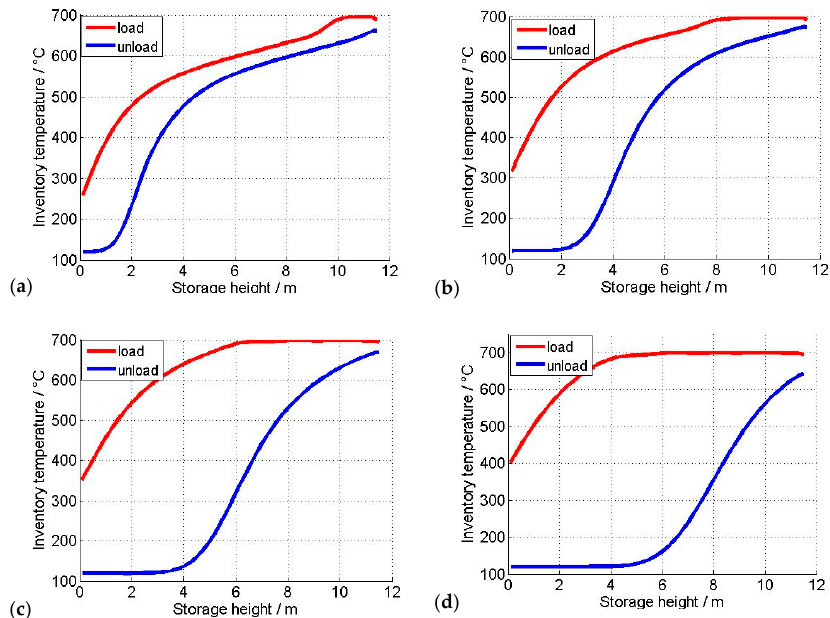
Figure 7. Partial load behavior: Temperature profiles of the inventory versus the storage height at the end of the charging and discharging process ( a ) 25% partial load, ( b ) 50% partial load, ( c ) 75% partial load, ( d ) Full load (reference).